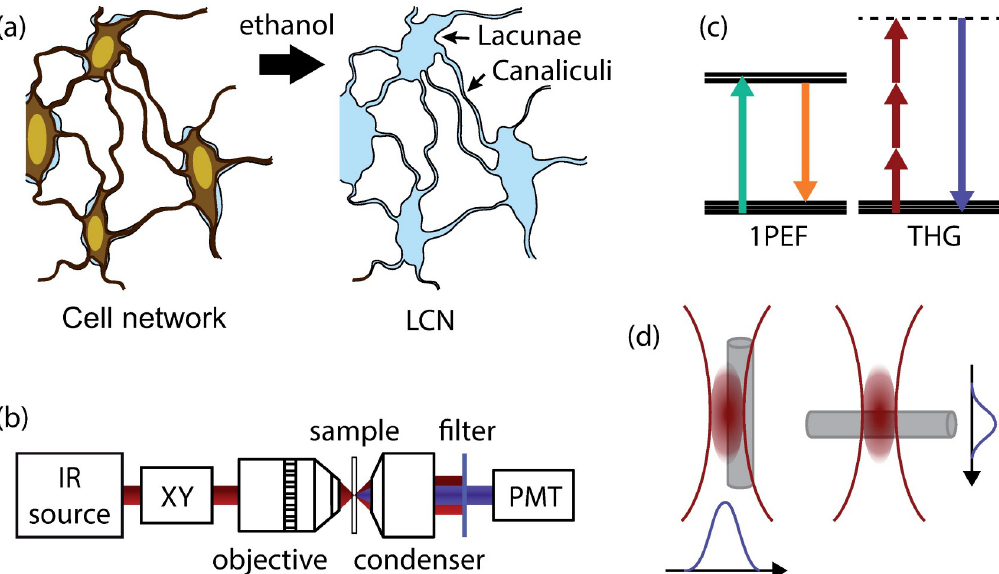
Fig 1. Bone structure, THG microscopy setup and principle. (a) simplified view of the osteocyte network in cortical bone (left) and the corresponding cavities in the bone matrix forming the lacuno-canalicular network (LCN). (b) Microscopy setup: a pulsed infrared 1180 nm beam is scanned and focussed on the sample, and the THG signal is collected in transmission onto a photomultiplier tube (PMT) using a 1.4NA condenser. (c) simplified Jablonski diagrams for single-photon excited fluorescence used in our confocal microscopy experiments (1PEF, left), and third-harmonic generation (THG, right). The THG signal is created at exactly one third of the excitation wavelength. Dotted line, virtual energy level. (d) the coherent buildup of the THG signal and the excitation phase shift of the excitation beam at the focal spot result in a non-zero signal only in the presence of optical heterogeneities within the focal volume, as created by canaliculi in the mineralized collagen bone matrix. This signal is strongly dependent on the canaliculi diameter and